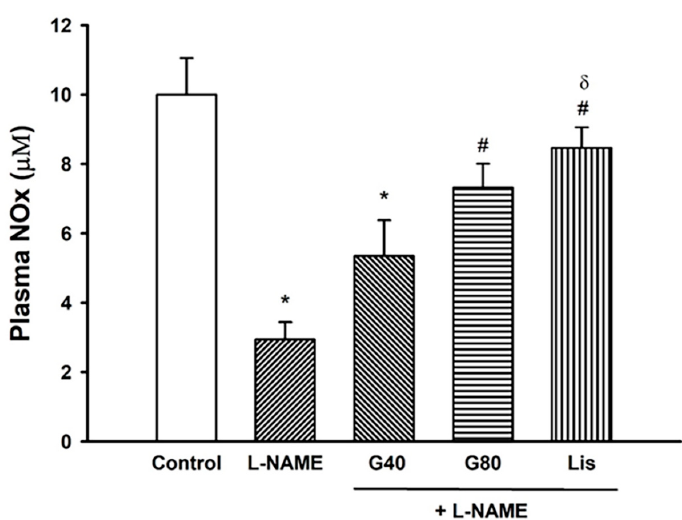
Figure 6. Effect of genistein or lisinopril on plasma nitric oxide metabolites (NOx) in rats treated